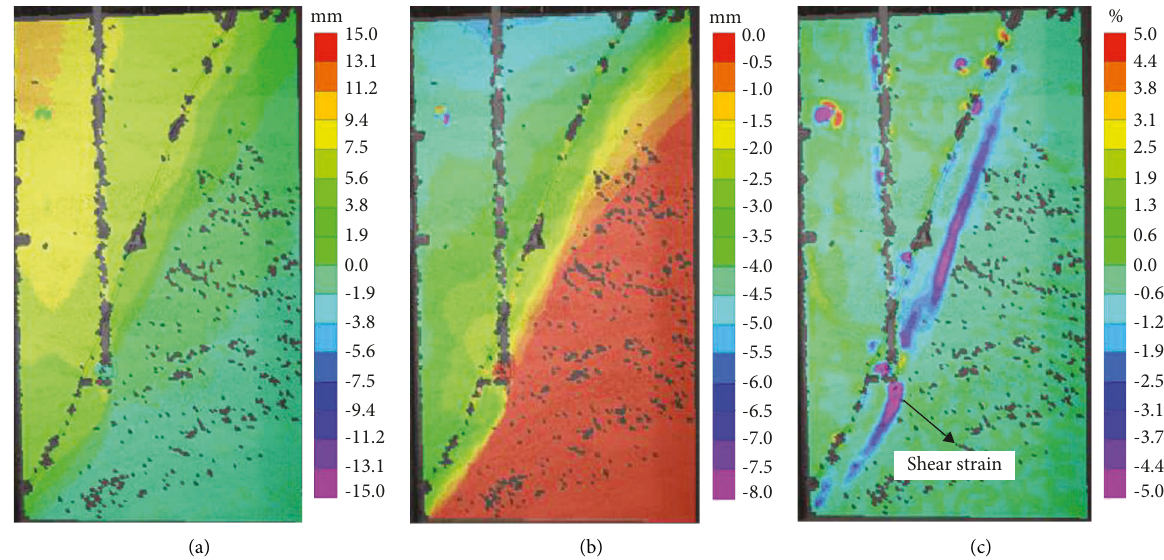
Figure 10: The ground displacement in sample M2; (a) the vertical settlement, (b) the horizontal displacement, and (c) the shear strain.